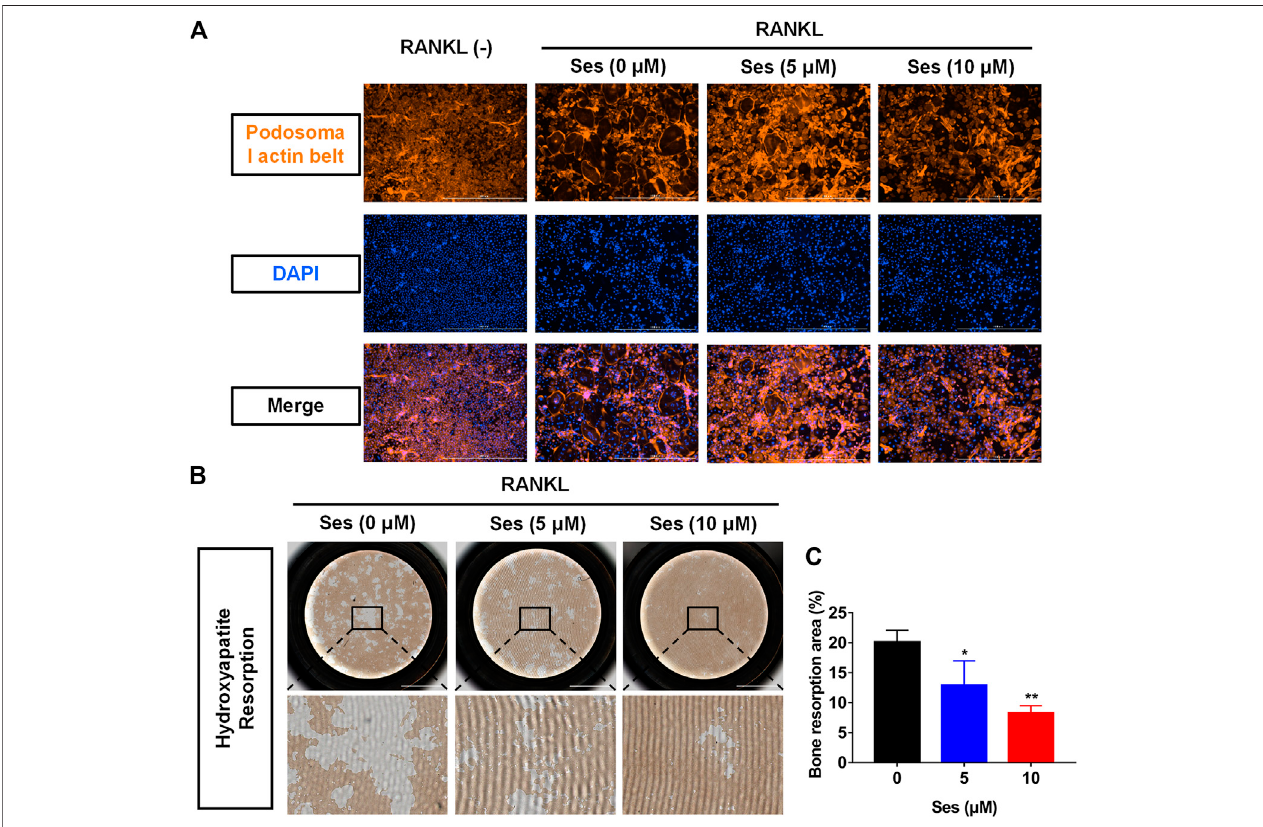
FIGURE 3 | Ses inhibits the bone resorption activity of mature osteoclasts in vitro . (A) Representative images of podosome belt formation in osteoclasts treated withdifferentconcentrationsofSes.The actin cytoskeleton (red) and nucleus (blue) ofosteoclasts werestained(scale (cid:1) 1,000 μ M). (B) AftertreatmentwithSes,ImageJ was used to analyze the bone resorption area of each group (scale (cid:1) 2,000 μ M). (C) Ses inhibited the bone resorption area of osteoclasts induced by RANKL in a dose- dependent manner (scale (cid:1) 2,000 μ M). The above data are expressed as the mean ± SD; n (cid:1) 3; * p < 0.05, ** p < 0.01, and *** p < 0.001. Ses, sesamolin; RANKL, receptor activator of nuclear factor- κ B